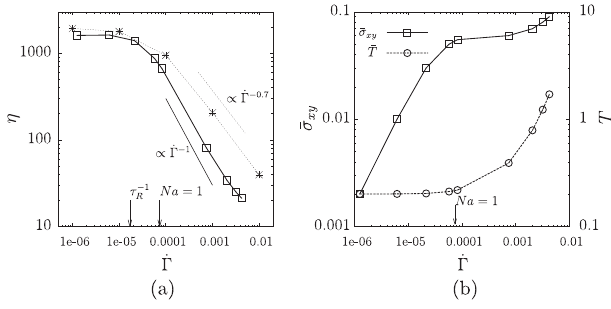
_ Γ FIG. 4. (a) The apparent viscosity η , defined as η ¼ σ 0 = , and (b) the spatial averages of the shear stress and temperature ¯ σ xy and _ Γ ¯ T , as functions of the gross shear rate . In (a), the asterisks show the results of the viscosity for a uniform temperature T ¼ 0 . 2 , i.e., Na ¼ 0 , obtained by the NEMD simulations. The downward arrows in both panels represent the shear rate at which the Nahme-Griffith number Na defined in Eq. (4) equals